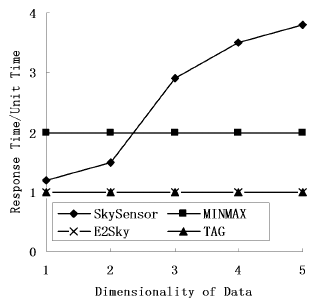
Figure 12. Response times under different data dimensionalities.